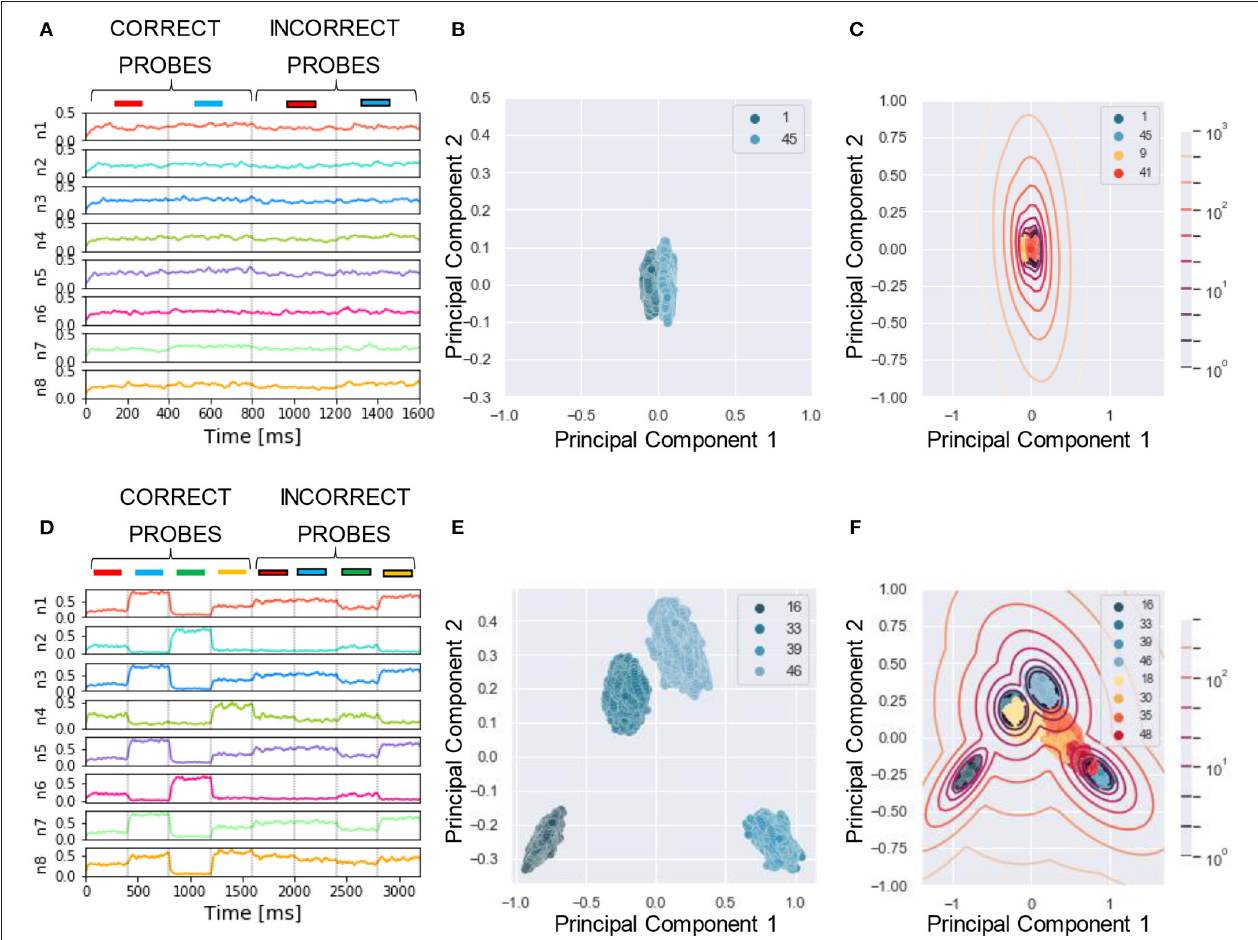
FIGURE 4 | Experiment 1—output dynamics and clustering. (A–C ) refer to the results of Experiment 1 on synthesized sounds with a single mixture presented during training. (D–F) refer to the results of Experiment 1 on synthesized sounds with three mixtures presented during training. The “correct probes” are the target and the distractor sounds composing the mixtures presented during training, while the “incorrect probes” are sounds not presented during training. The numbers in the legends indicate the sound IDs. (A) Voltage dynamics of the 8 output neurons during inference, when the target, the distractor and the two associated incorrect probes are tested. The neuron population is not able to respond with different dynamics to the four sounds, and the voltage of all the output neurons fluctuates randomly throughout the whole testing sequence. (B) The PCA projection of the datapoints belonging to the two targets (in blue) shows that the clusters are collapsed into a single cluster. (C) When GMM is applied, all the datapoints representing both the correct probes (in blue) and the incorrect probes (in orange and red) fall within the same regions, making it impossible to distinguish the different sounds based on the population dynamics. (D) Voltage dynamics of the 8 output neurons during inference, when the four targets and the associated distractors are tested. As expected, the neuron population has learnt the feature of the different sounds and responds with different dynamics to the eight sounds. Each output neuron exhibits an enhanced response to one or few sounds. (E) The PCA projection of the datapoints belonging to the four correct probes (in blue) shows that the clusters are compact and spatially distant one from the other. (F) When GMM is applied, the model shows that the network is, most of the times, able to distinguish the target and distractors (in blue) from the incorrect probes (in yellow, orange and red). The correct probes are never overlapped. Three of the four distractors fall far from the targets’ region, while the fourth (in yellow) overlaps with one of the targets. These results are overall coherent with the human performance. In (C,F) , the contour lines represent the landscape of the log-likelihood that a point belongs to one of the clusters associated to the correct